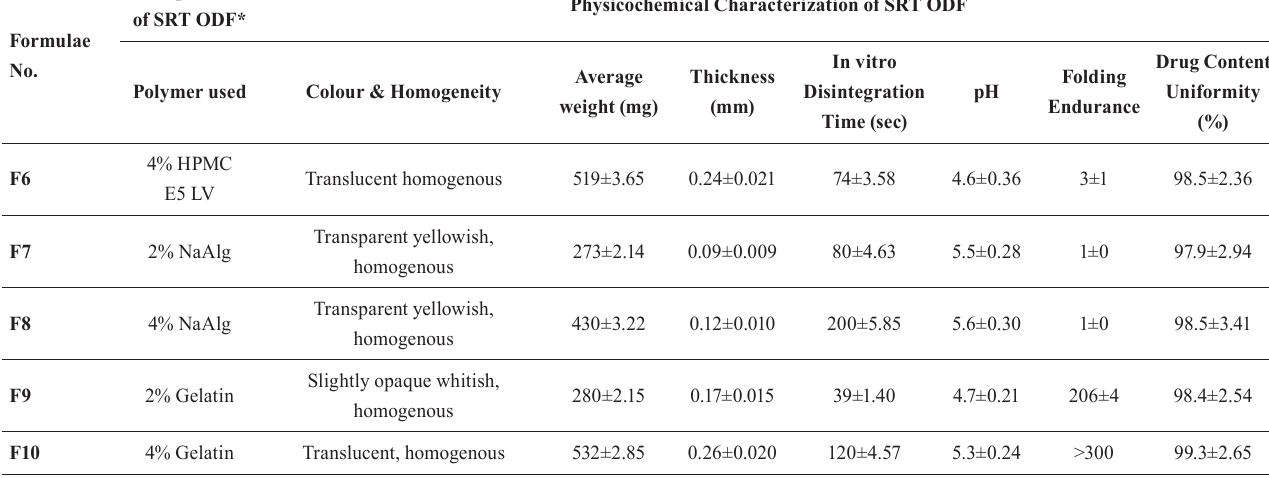
TABLE I - C omposition and physicochemical characterization of SRT ODFs